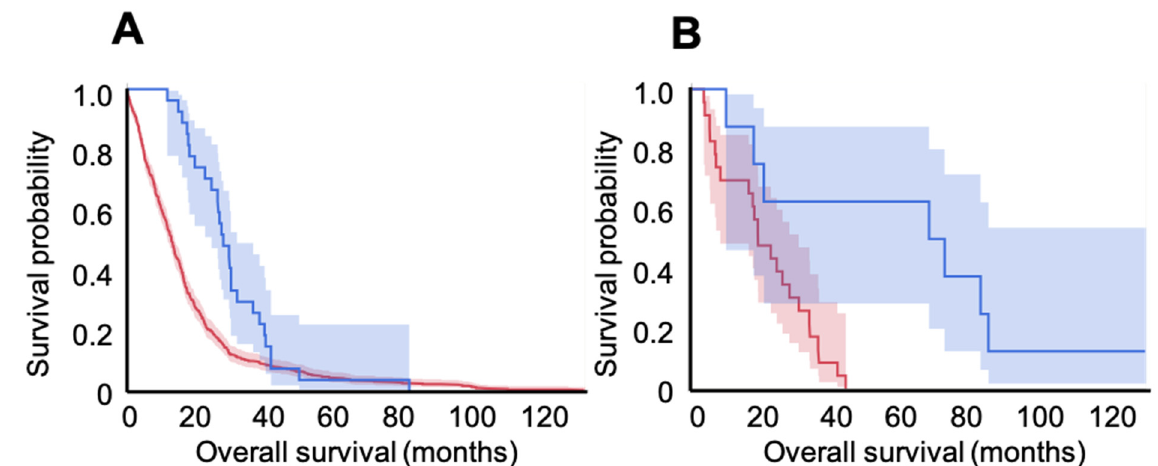
Figure 2. Kaplan–Meier survival curves and respective 95% confidence intervals for vaccinated (blue) versus unvaccinated GDC bank (red) patients with glioblastoma ( A ) and those with grade 4 astrocytoma ( B ). A. In the GBM group, OS was 16.3 ± 0.7 months for the GDC patients (n = 572) and 27.6 ± 2.4 months in the vaccinated population (n = 28; log-rank p < 0.001). In the Astro-4 group, OS was 19.8 ± 2.5 months for the GDC population (n = 23) and 59.5 ± 15.9 for the vaccinated patients (n = 9; log-rank p < 0.01).